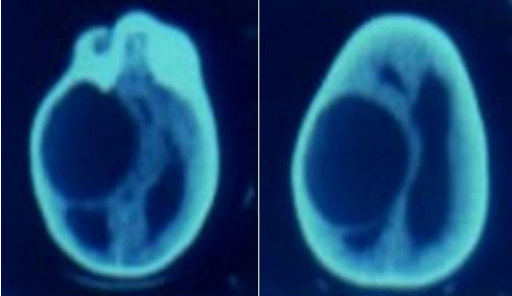
Figure 2. Cerebral MRI (T1: T1-weighted, T2: T2- weighted, Diff: diffusion-weighted, T1+G: T1- weighted with Gadolinium injection): Two cerebral hydatid cysts: unilocular right frontal and multilocular left parietal.